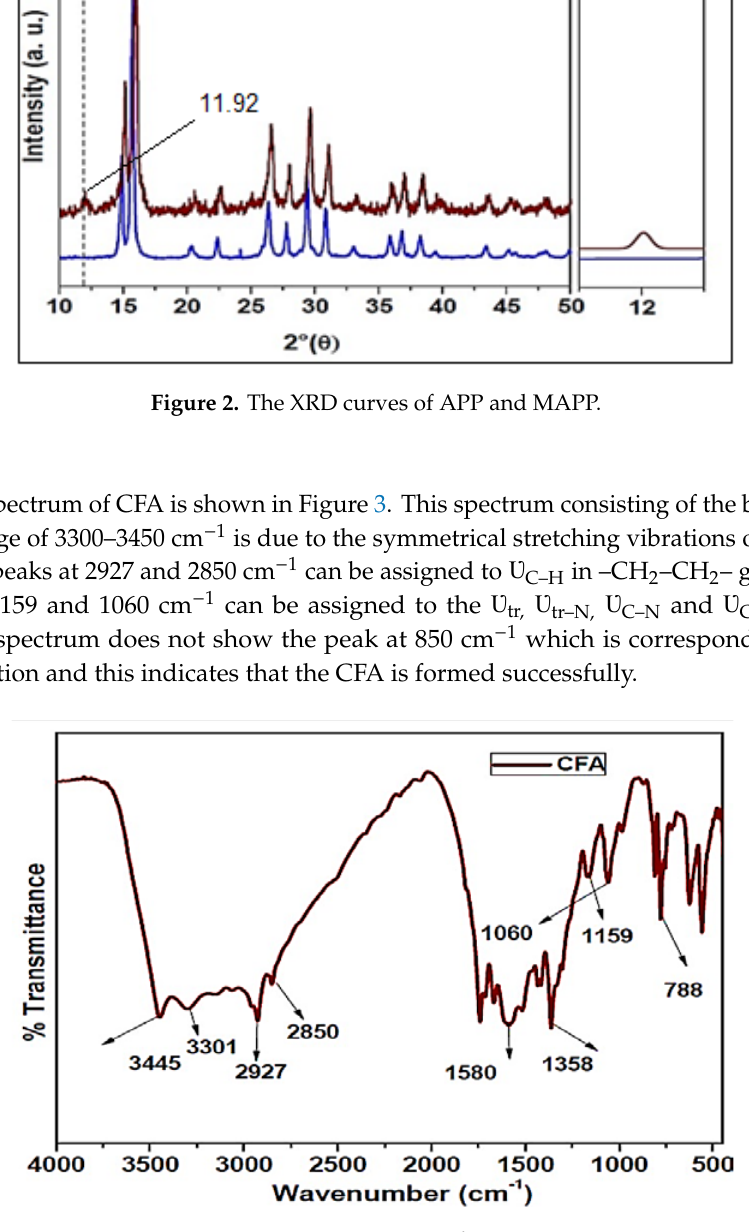
Figure 3. FTIR curve of CFA.